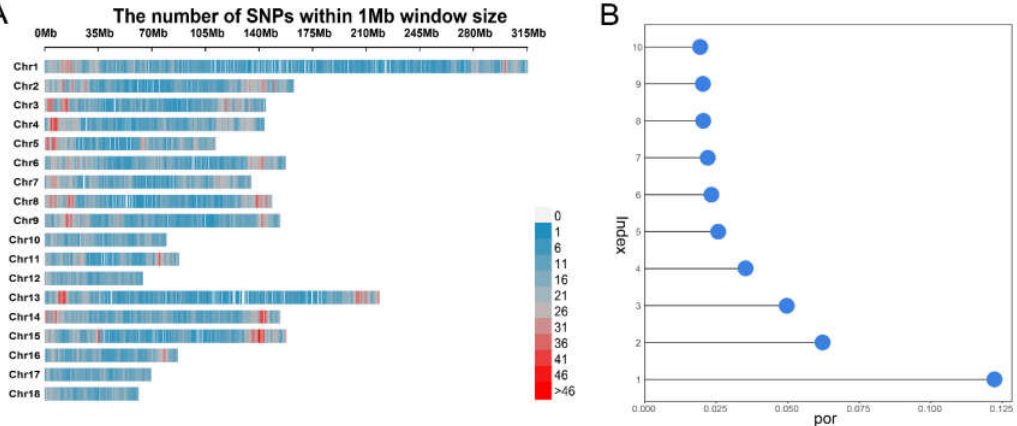
Figure 2. The distribution of SNPs on autosomal chromosomes and the principal component analysis. ( A ), The distribution of SNPs within a 1 Mb window size. ( B ), The lollipop-plot of top ten principal components. Index means top ten principal components and por represents proportion of explained variance.